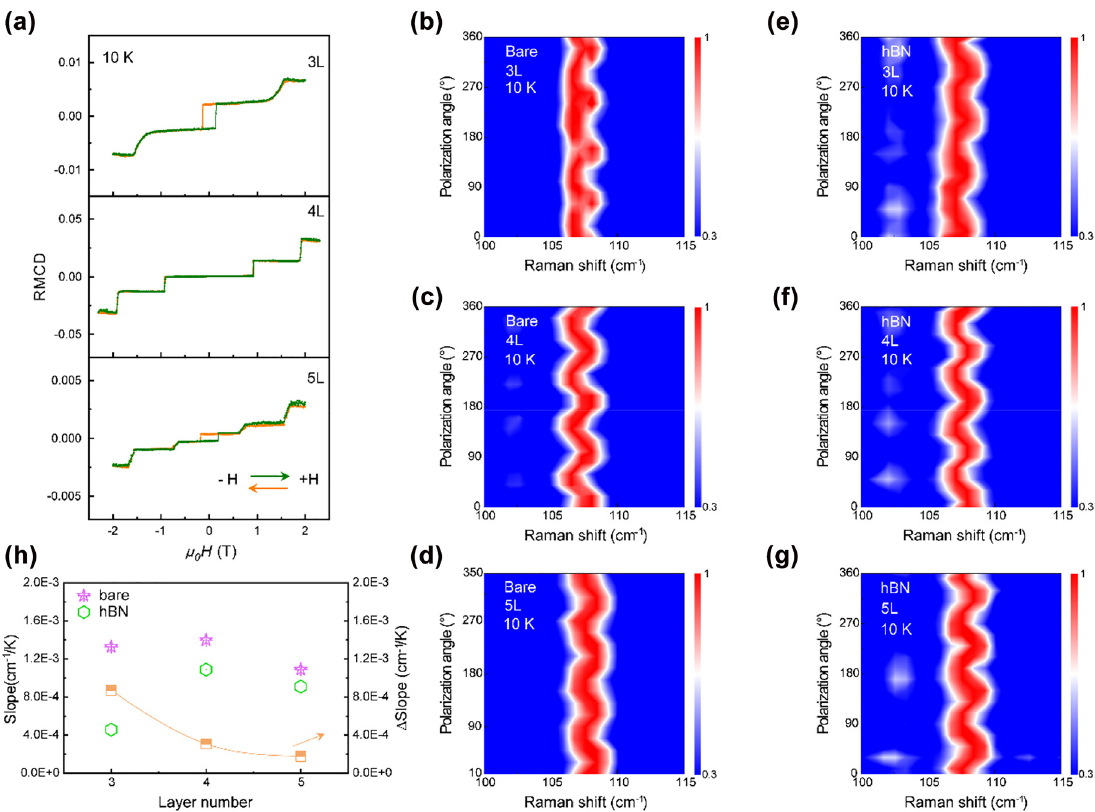
. (a) RMCD signals of 3–5L CrI as a function of magnetic field taken Figure 3: Intrinsic monoclinic phase of bare and encapsulated 3–5L CrI 3 3 at 10 K. The orange (green) curve represents the magnetic field is swept from + 2 ( − 2) to − 2 ( + 2) T. (b)–(d) Polarization angle dependence of at 10 K. (e)–(g) Polarization angle dependence of Raman spectra of bare 3–5L CrI at 10 K. Raman spectra of hBN-encapsulated 3–5L CrI 3 3 Both of them show fourfold dependence patterns, in agreement with monoclinic stacking. (h) The extracted slopes of Raman mode energy . The slopes of the hBN-encapsulated samples are lower than that of the corresponding difference of bare and hBN-encapsulated 3–5L CrI 3 bare samples with the same layer-number, indicating the spring damping effect of hBN layers on structural phase transition.